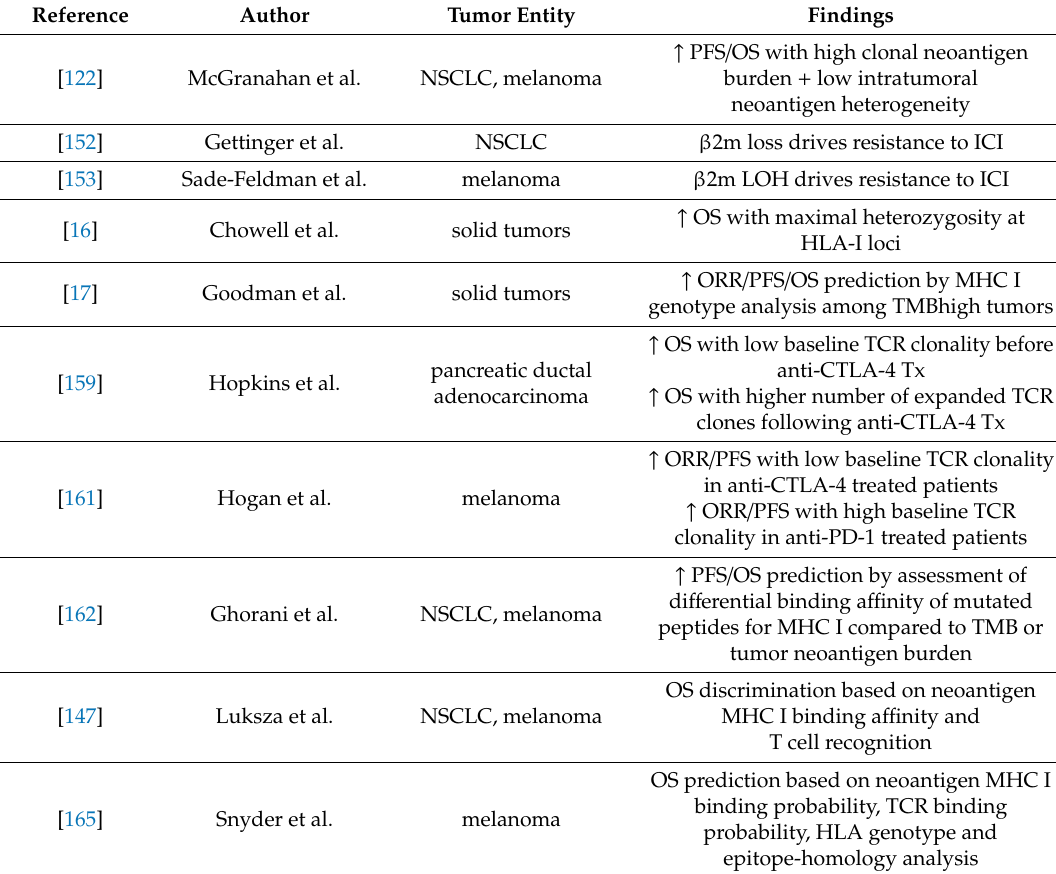
Table 5. Impact of the antigen presenting pathway and T cell receptor (TCR) repertoire on clinical outcome with immune-checkpoint inhibitors